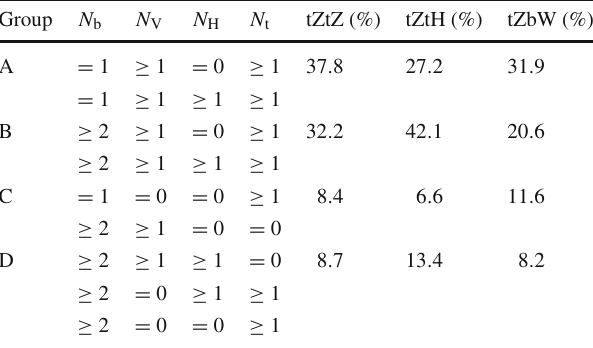
Table2 Thefirstfourcolumnsshowdifferenteventgroupsusedforthe TT search, classified according to the number of b-tagged jets N b and the number of V → qq, H → bb, and t → qq (cid:7) b candidates in the event, N V , N H and N t , respectively, identified using both the jet substructure andresolvedtaggeralgorithms.Thelastthreecolumnsshowtherelative signal acceptance for a T quark of mass 1200GeV for decay channels tZtZ, tZtH and tZbW as described in text